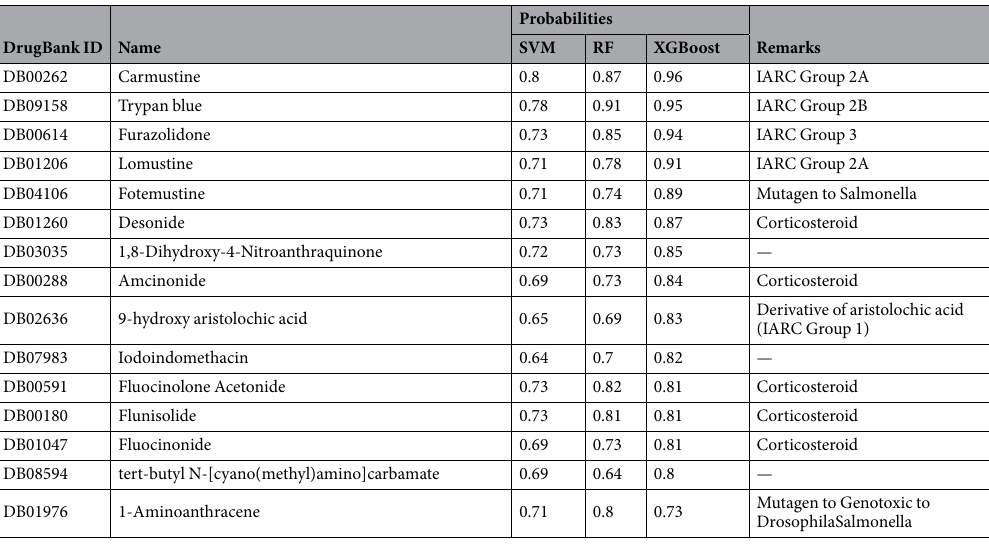
Table 6. Predicted carcinogenic drugs with predicted probabilities >